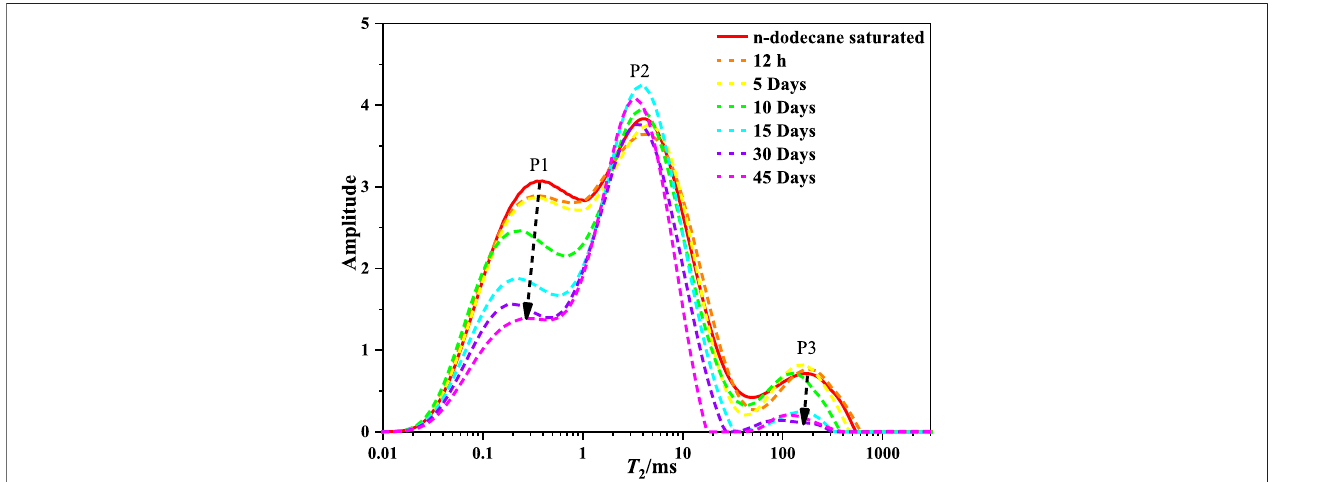
FIGURE 10 | T2 spectral curves of Sample 5 during the process of spontaneous imbibition.